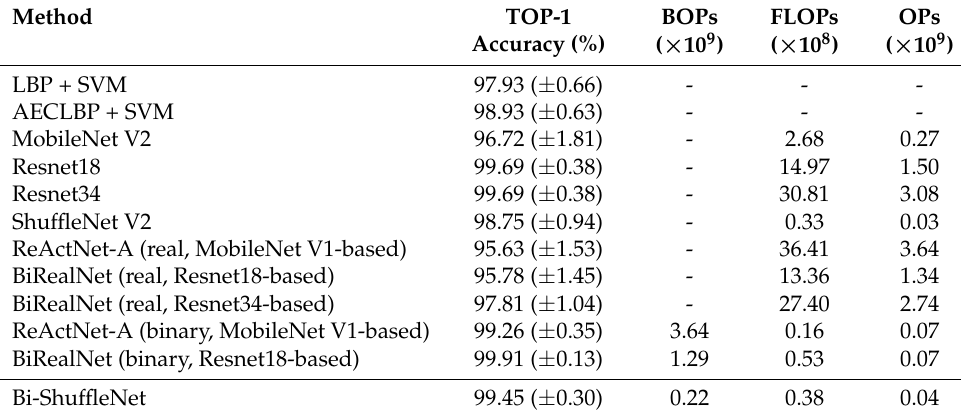
Table 2. Coarse-grained defect detection performance on